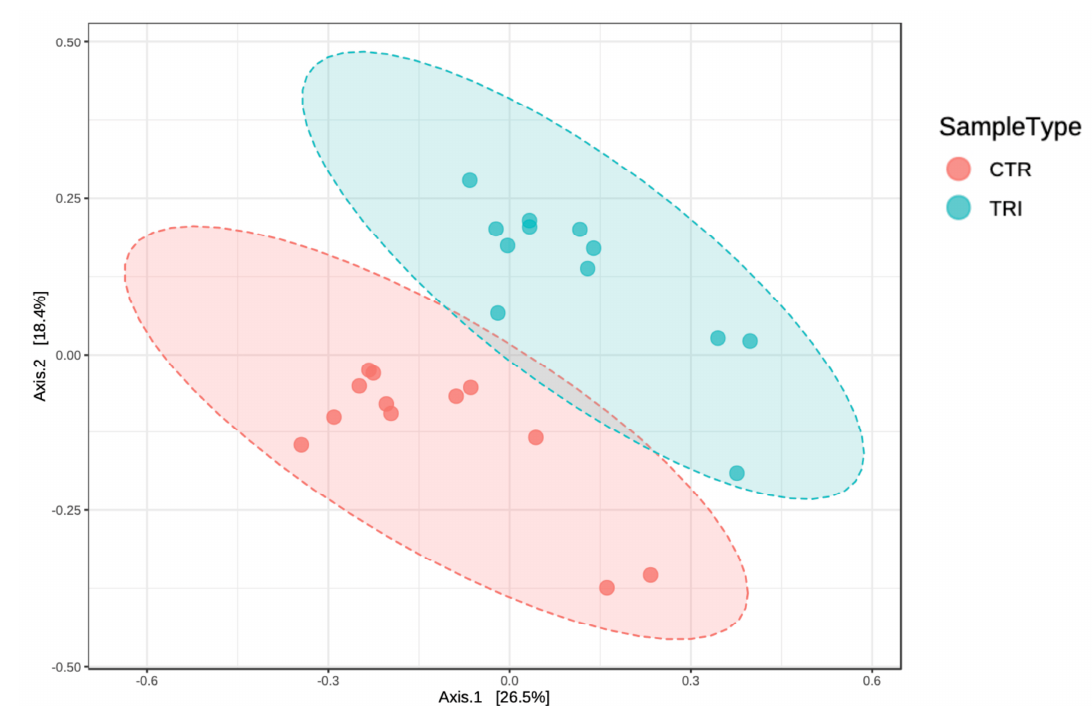
Figure 1. Principal coordinates analysis (PCoA, Bray-Curtis distance) plot of the gut microbiota of weaning piglets fed a diet with (TRI) or without tributyrin supplementation (CTR) (R2 = 0.19, p < 0.01).